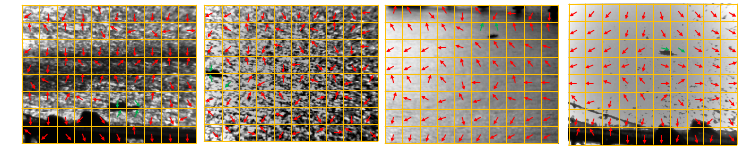
Figure 2. Orientational gradient distribution diagram. the average gray level of the foreground and the background. For the convenience of the observation, the competitive area with the same or a higher local contrast as the target area is marked as green, as shown in Figure 3.